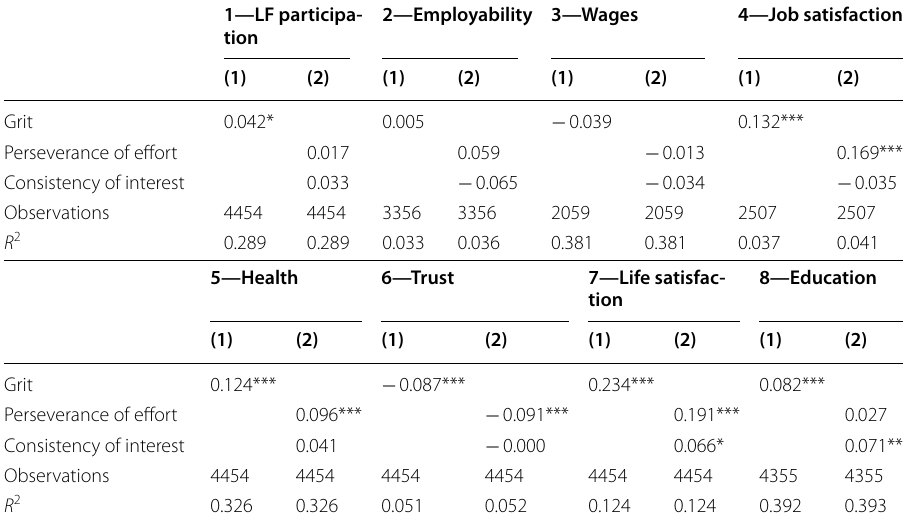
Table 13 Comparison of the unidimensional and the two-factor Grit